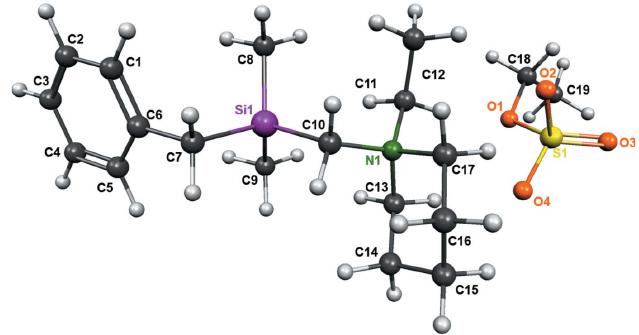
Figure 1 ( a ) The molecular structure of 1 illustrated using SCHAKAL99 (Keller, 1999). ( b ) The molecular structure of 1 showing 50% displacement